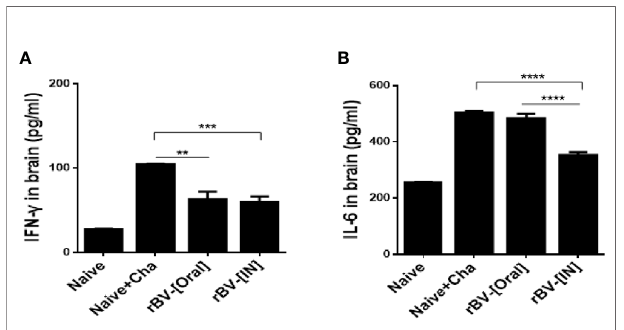
FIGURE 6 | Inhibition of pro-in fl ammatory cytokines in the brain. Brains of mice were collected 16 days after T. gondii challenge infection. The levels of the pro- in fl ammatory cytokines IFN- g (A) and IL-6 (B) were determined in the brain supernatant. Data are presented as mean ± SD and asterisks indicate statistical differences between groups. (** P < 0.01, *** P < 0.001, **** P